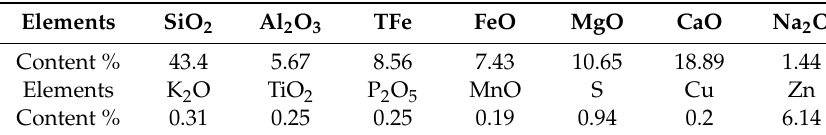
Table 2. Mineralogical composition of fine tailings.